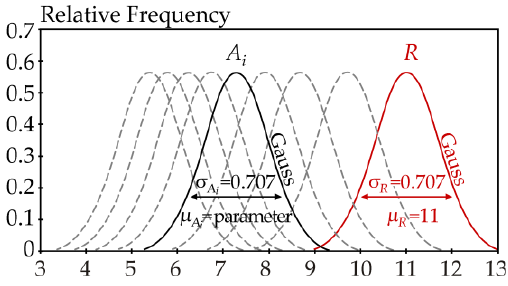
Figure 6. Gaussian limit state model with parameter μ A .